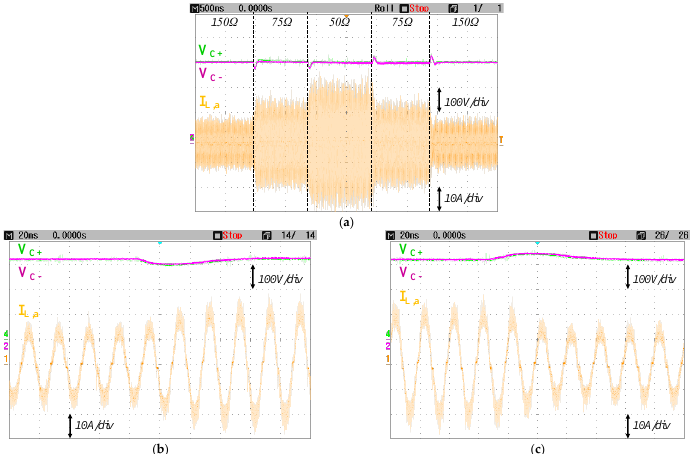
Figure 20. DPSSOCC performances with resistive load variations: ( a ) between 150 Ω and 50 Ω , ( b ) transient from 75 Ω to 50 Ω (zoom) and ( c ) transient from 50 Ω to 75 Ω